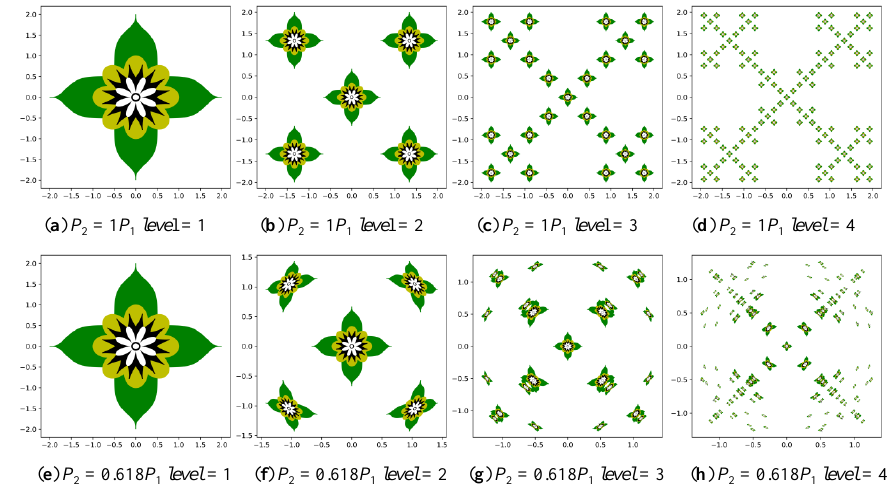
Figure 8. Layout patterns generated by setting parameters P 2 = 1 P 1 and 0.618 P 1 and level = 1, 2, 3, and 4.